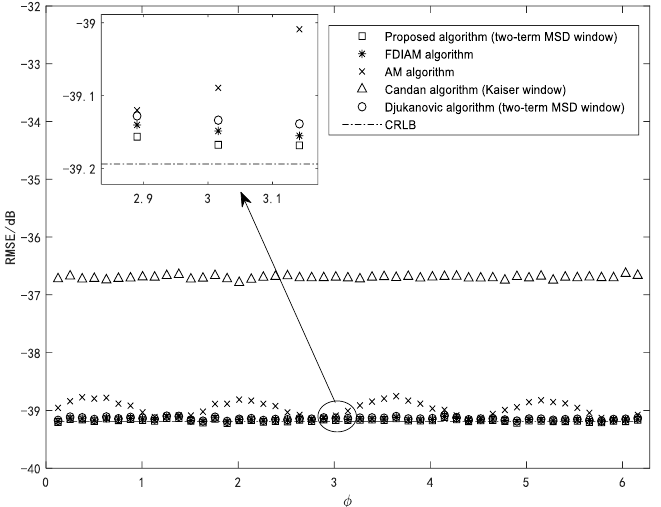
Figure 4. RMSEs versus φ for N = 128, f 0 = 0.1917, and SNR = 10 dB.